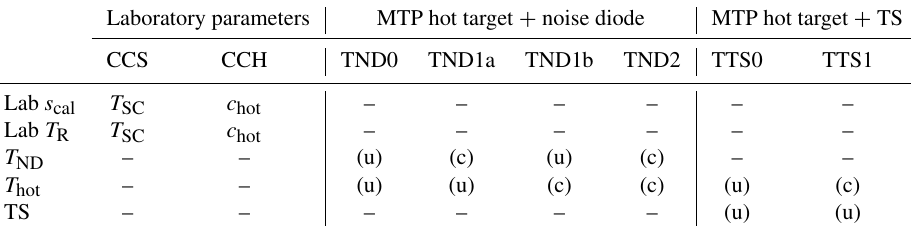
Table 6. Calibration methods tested with MTP data. T SC indicates linking of the parameters to the scanning unit temperature, and c hot indicates linking to the hot target measurement signal. Usage of uncorrected data is denoted with a (u), and applied corrections are indicated with a (c).